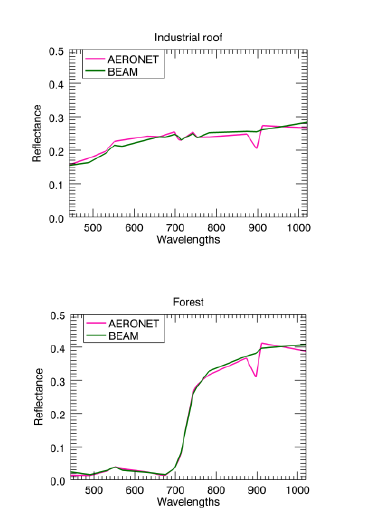
Figure 5. The surface reflectance obtained using the BEAM tool and applying the CHRIS@CRI algorithm using AERONET data for two different targets, an industrial roof (top) and a vegetated area